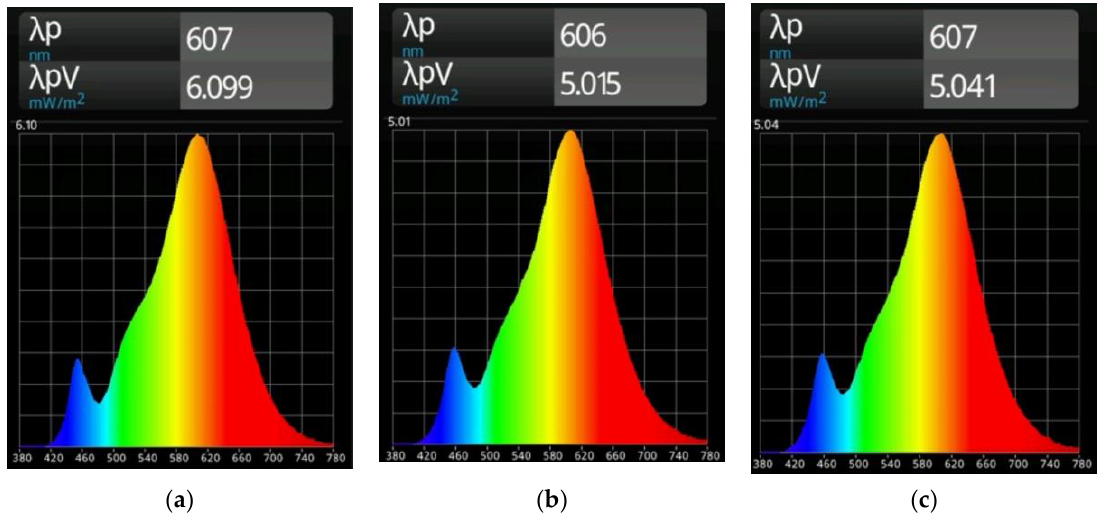
Figure B2. Comparison of spectral light distributions after switching on a LED in room 3. Measure- ments were taken at 0 min ( a ); 30 min ( b ), and at 60 min ( c ).